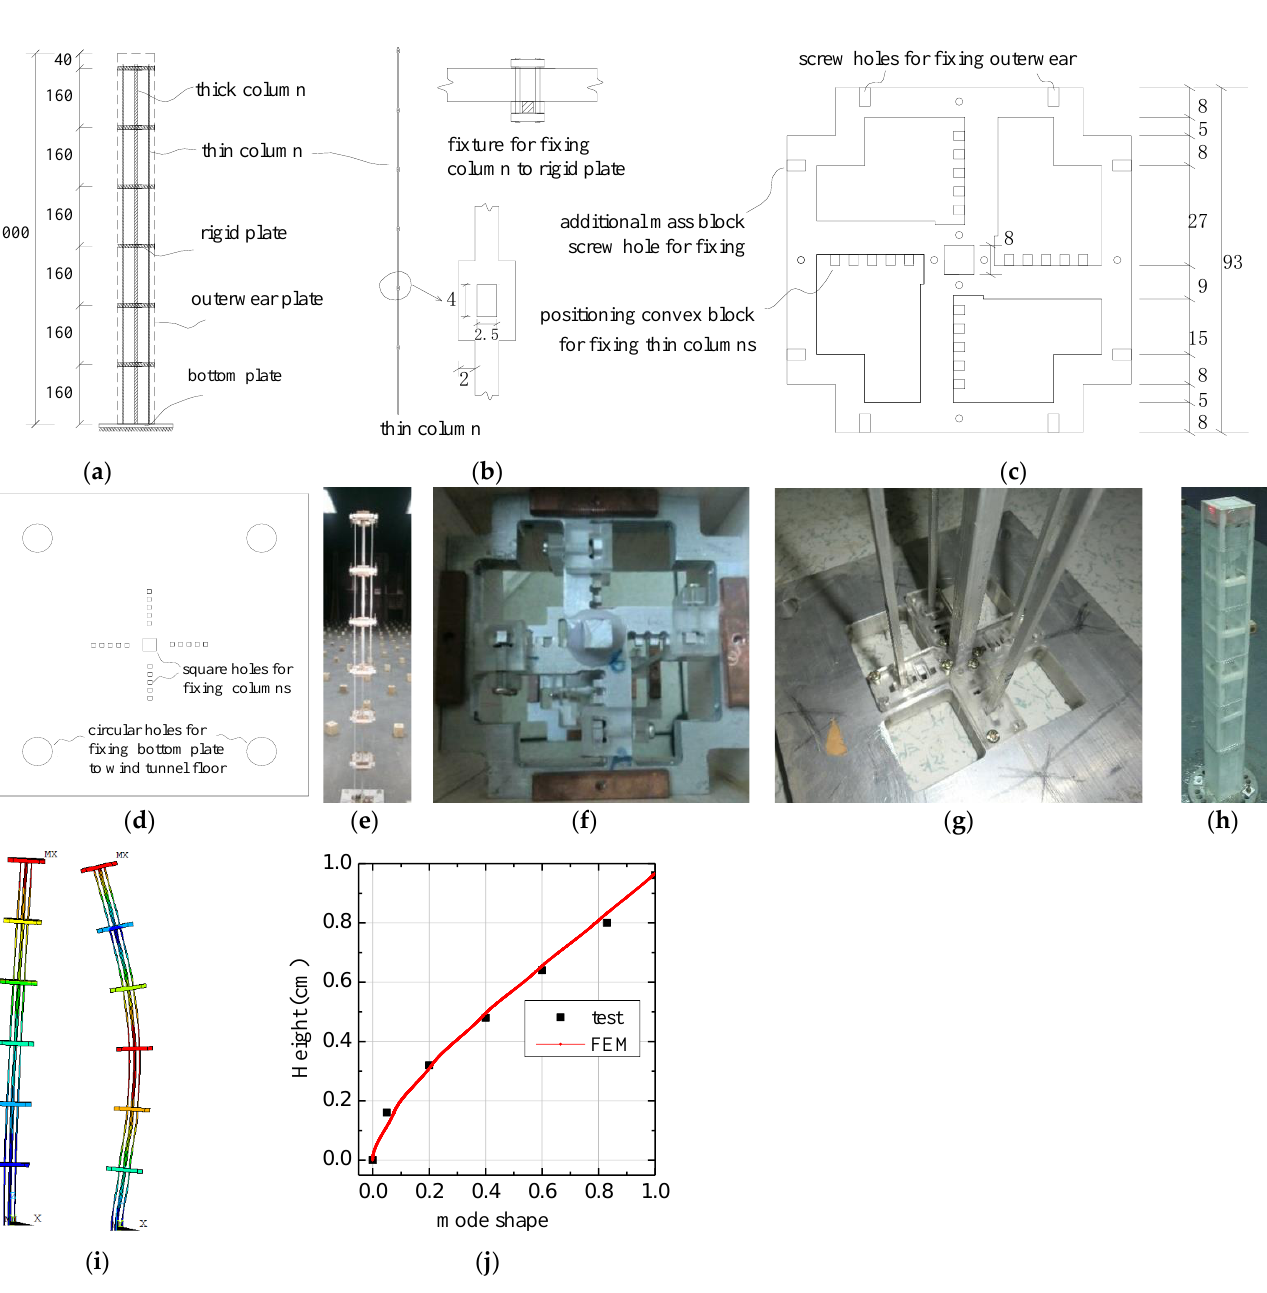
Figure 1. Design of the MDOF (unit: mm): ( a ) design of skeleton; ( b ) design of column and fixture; ( c ) design of rigid plate; ( d ) design of bottom plate; ( e ) skeleton photo; ( f ) photo of rigid plate; ( g ) photo of bottom plate; ( h ) completed model; ( i ) mode shapes of the completed model; ( j ) first sway mode shape derived from FEM and free vibration test.